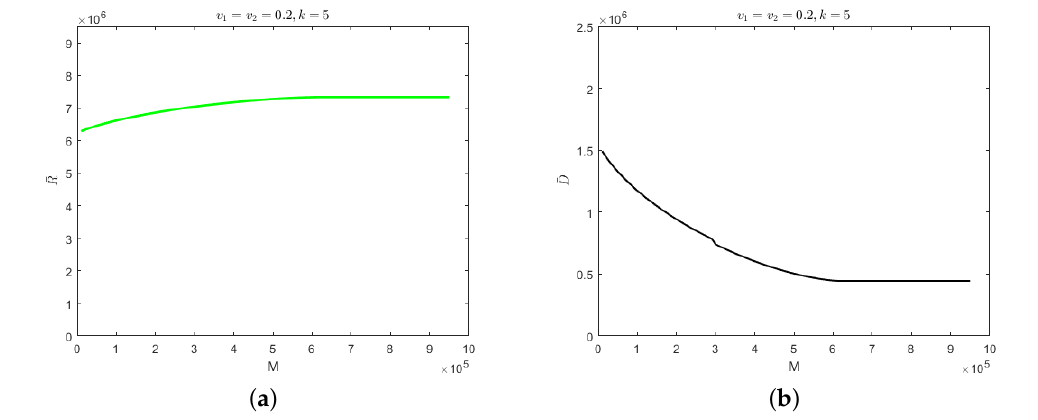
Figure 3. ( a ) Evolution results of the recovered cases when the medical resources is M ∈ [ 10 4 ,9.5 × 10 5 ] . ( b ) Evolution results of the deaths when the medical resources is M ∈ [ 10 4 ,9.5 × 10 5 ] .